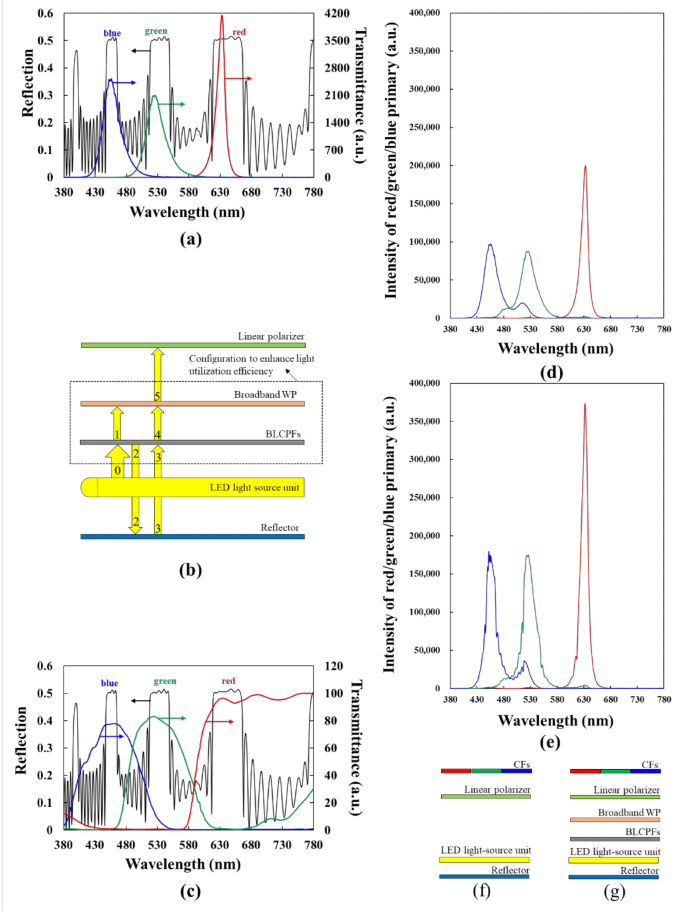
Figure 6. ( a ) Simulation results of the reflection spectrum (black curve) of a designed BLCPF containing three di ff erent reflection bands. The red, green, and blue curves are spectra of three emission bands of a LED light source. ( b ) Configuration of the usage of the designed BLCPFs and a broadband WP to improve the light-utilization e ffi ciency and color gamut of LCDs / light-source unit based on ( a ). ( c ) Simulation results of the reflection spectrum (black curve) of a designed BLCPF, which is identical to that in ( a ). The red, green, and blue curves are the transmittance spectra of red, green, and blue CFs. The calculated intensities without [with] the use of the designed BLCPFs and broadband WP ( a c_w / o ) [( a c_w / )] of red, green, and blue primary colors as functions of wavelength ( λ ) curve ( d) [( e )] using the configuration plotted in ( f) [( g )]. ( f ) and ( b ) are the same except that the CFs and the BLCPFs with the broadband WP are added and removed in ( f ), respectively; ( g ) and ( b ) are the same, except that the CFs are added in ( g